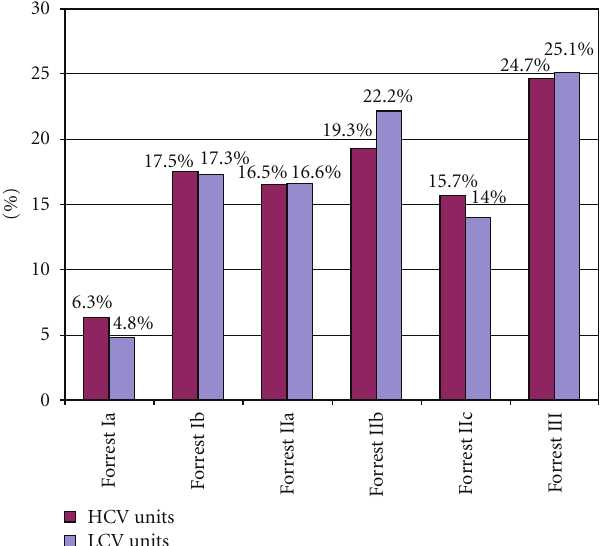
Figure 1: Proportion of bleeding ulcers according to Forrest classification in high case volume (HCV) and low case volume (LCV) units.